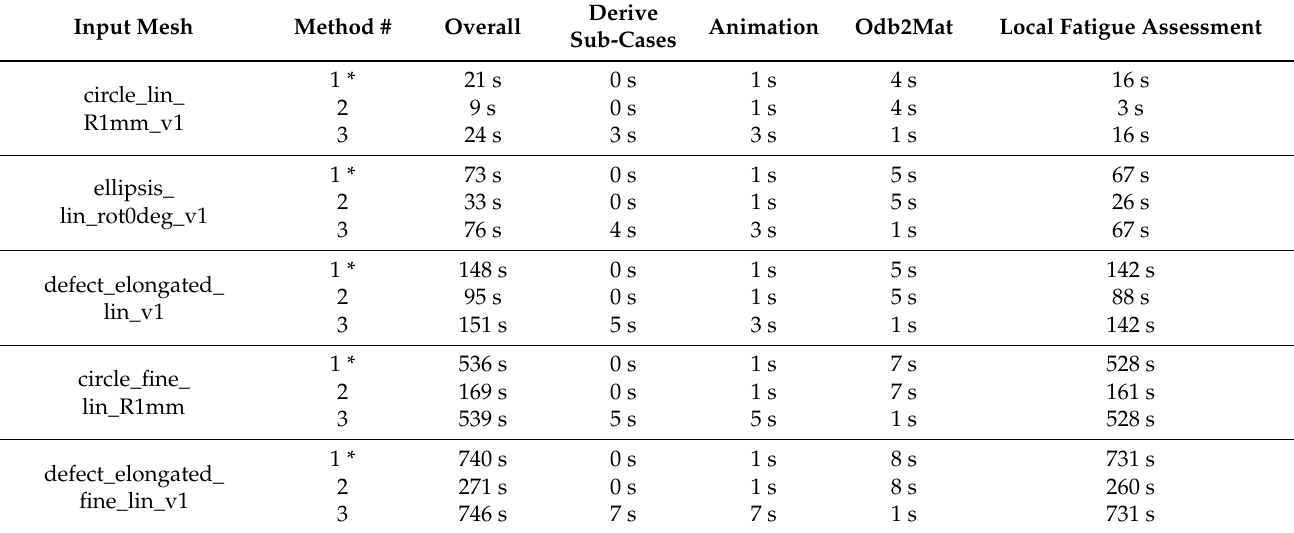
Table 11. Measured computational effort for post-processing of the three characteristic defect geome- tries using single-core processing for one load vector ( ϕ = 0 ◦ )